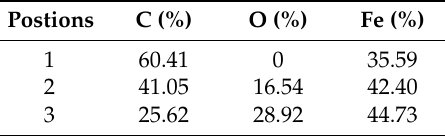
Figure 11. EDX spectra of different location from worn plate 3#: ( 1 ) the non-contact of the surface; ( 2 ) the worn dimple on the worn surface; and ( 3 ) the worn surface lubricated by the oil containing 0.01 wt % DS. Table 3. Elemental content (at.%) corresponding to the EDX spectra in Figure 10.